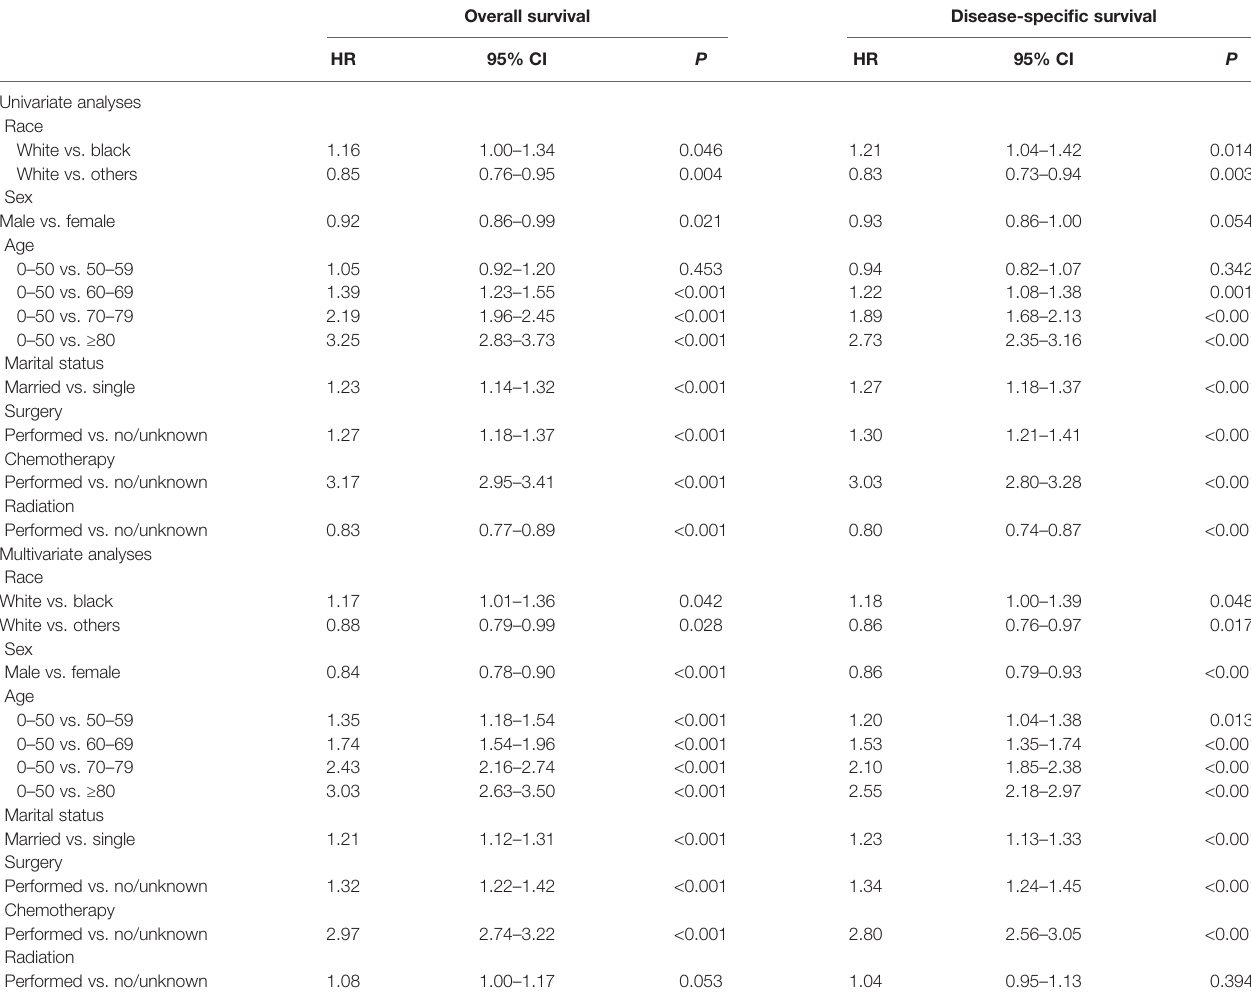
TABLE 4 | Univariate and multivariate Cox regression analyses of the ability of each factor in predicting OS and DSS among DLBCL patients.